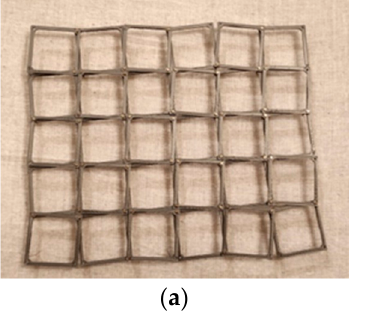
Figure 12. A 5 × 6 auxetic structure built with square frames connected by rotation axes on their surface in three positions closed ( a ), partially open ( b ) and open ( c ).